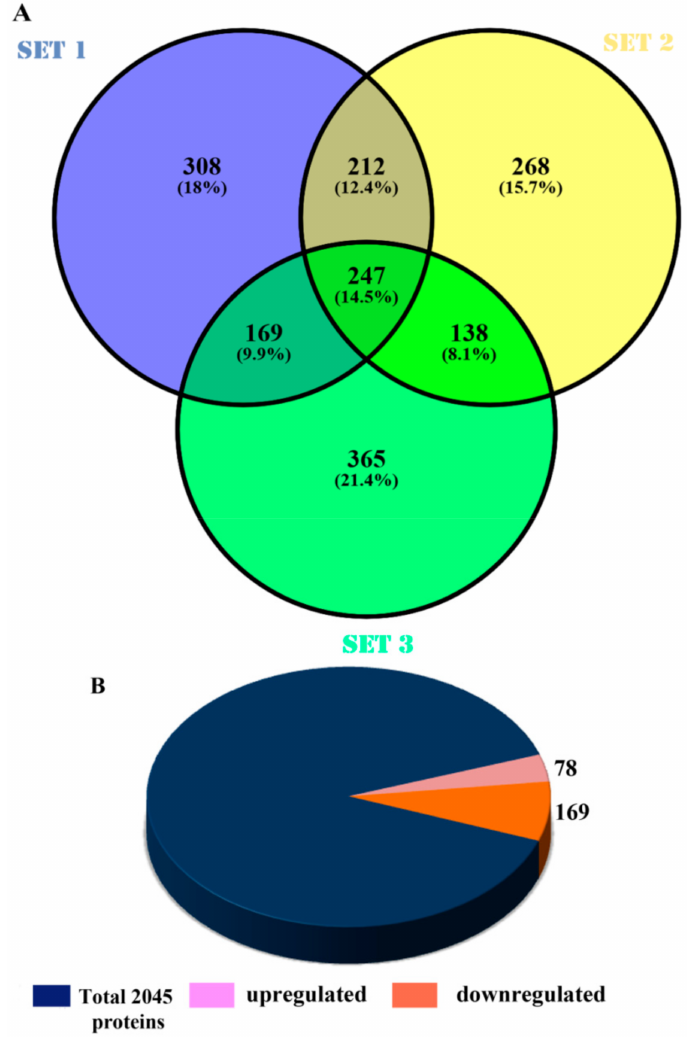
Figure 1. Results from VENNY 2.1. ( A ) Venn diagram showing the commonly affected proteins obtained in proteomic analysis. ( B ) Pie chart showing the fraction of the upregulated and downregulated